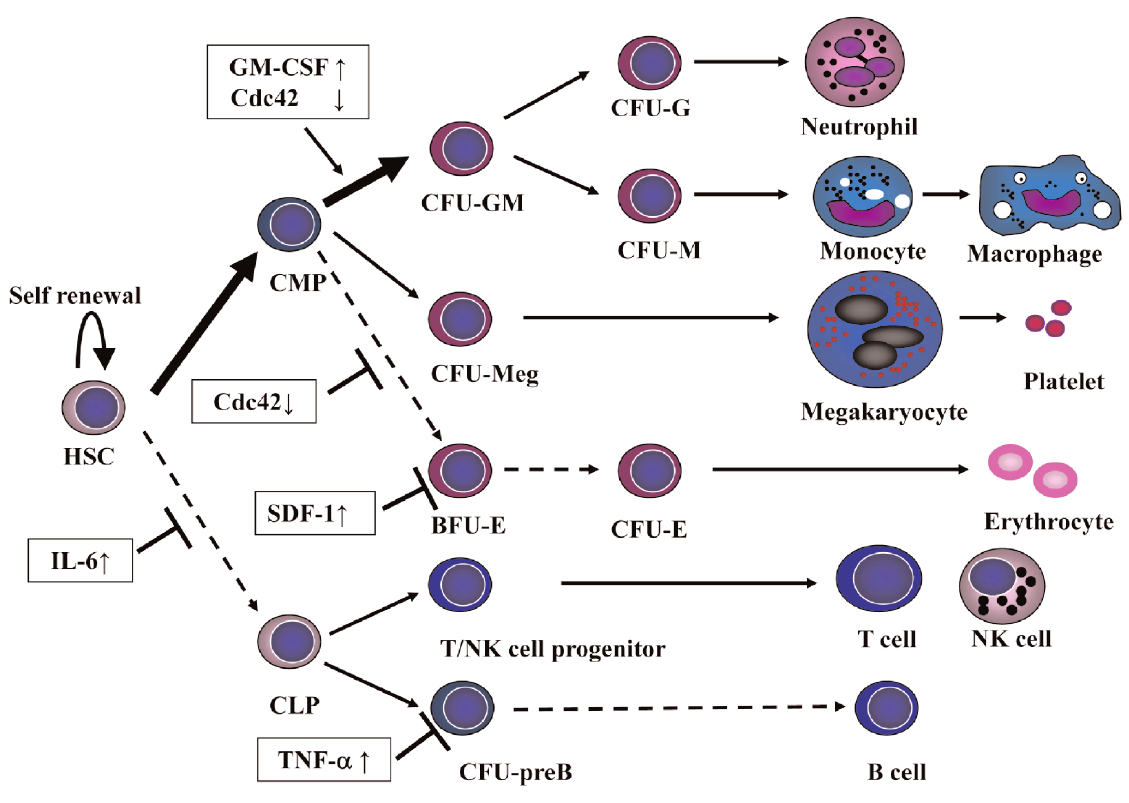
Figure 2. Up- and down-regulation of hematopoiesis by neopterin. Self-renewal and differentiation are the car- dinal functions of hematopoietic stem cells (HSCs). HSCs are multipotent cells that provide the descendent cells. There is a hierarchy of hematopoietic differentiation. HSCs diverge into the common myeloid progenitor cell (CMP) and the common lymphoid progenitor cell (CLP). These progenitor cells have a more limited spectrum of descendent cells and provide more mature progenitor cells that are committed to a single blood cell lineage and are able to proliferate. Neopterin activates stromal cells and induces them to produce cytokines such as IL-6 GM- CSF SDF-1 and TNF- α . Furthermore, neopterin downregulates the gene expression levels of cdc42 in hematopoi- etic progenitor cells; this downregulation may possibly be caused by activated stromal cell functions. The pro- duction of cytokines and the downregulation of cdc42 alter the differential direction of hematopoietic stem cells and hematopoietic progenitor cells, resulting in the stimulation of myelopoiesis and the suppression of B-lym- phopoiesis and